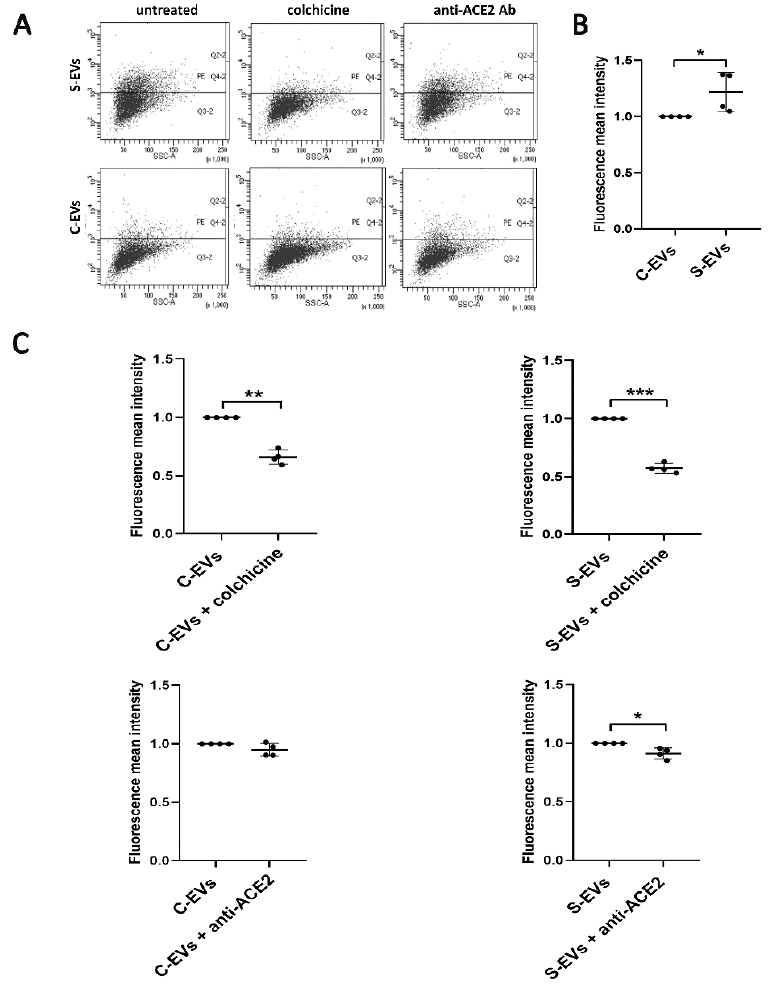
Figure 7. Effect of colchicine and anti-ACE2 blocking antibody on the EV uptake by the bronchial epithelial cell line 16HBE14o-. ( A ) Representative flow cytometry dot plots of S-EV or C-EV uptake without treatments (untreated) or with colchicine 150 µ M (S/C-EVs colchicine) or anti-ACE2 20 µ g/mL (S/C-EVs anti-ACE2 Ab). ( B ) Fluorescence mean intensity of all positive events